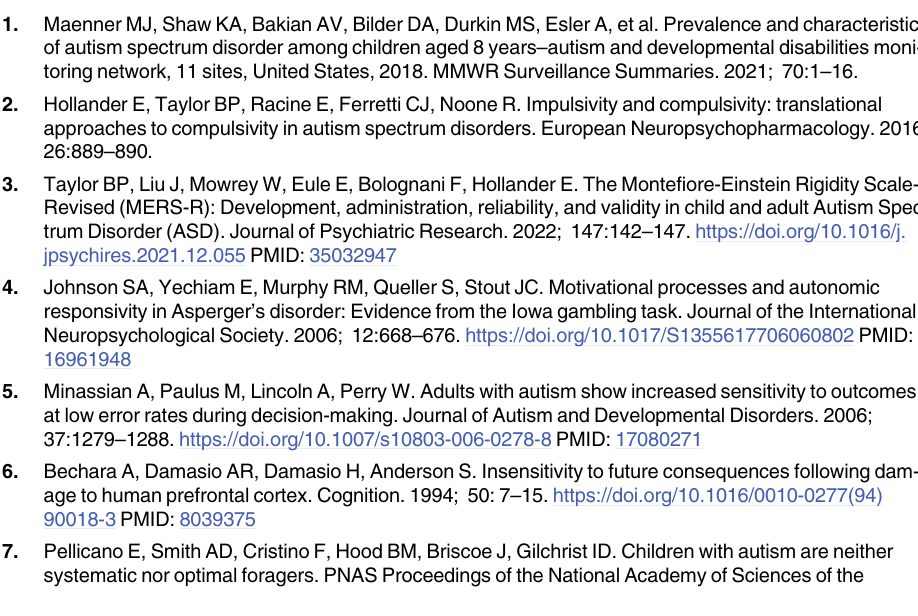
S1 Fig. Scatter plot of the relationship between choice switching and self-report